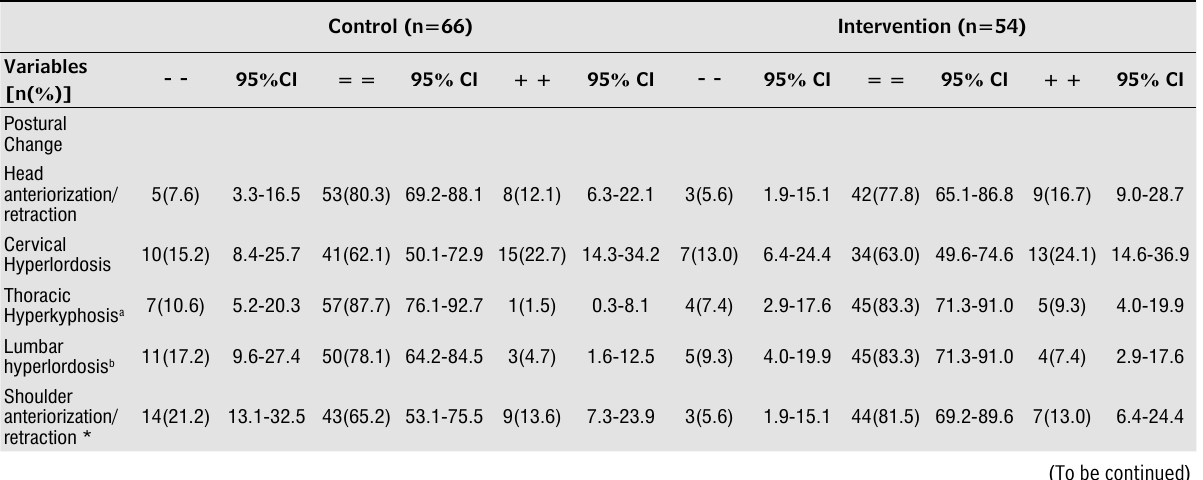
Table 3 – Posture and pain expressed in frequencies [ n( % ) ] and confidence intervals (95 %